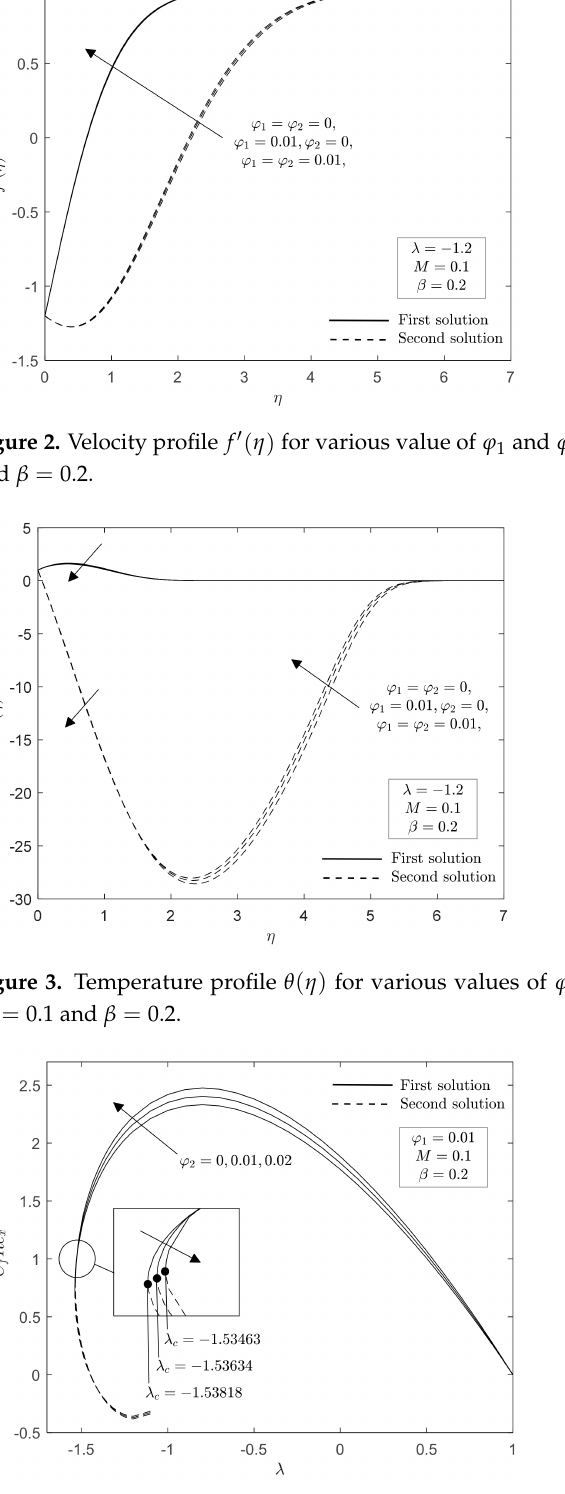
Figure 4. Skin friction coefficient C f Re 1/2 x with λ for some values of CoFe 2 O 4 nanoparticle volume fraction ϕ 2 when M = 0.1 and β =